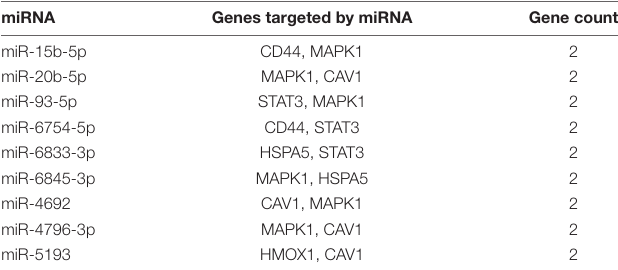
TABLE 5 | miRNAs and its target genes. miRNA Gene count